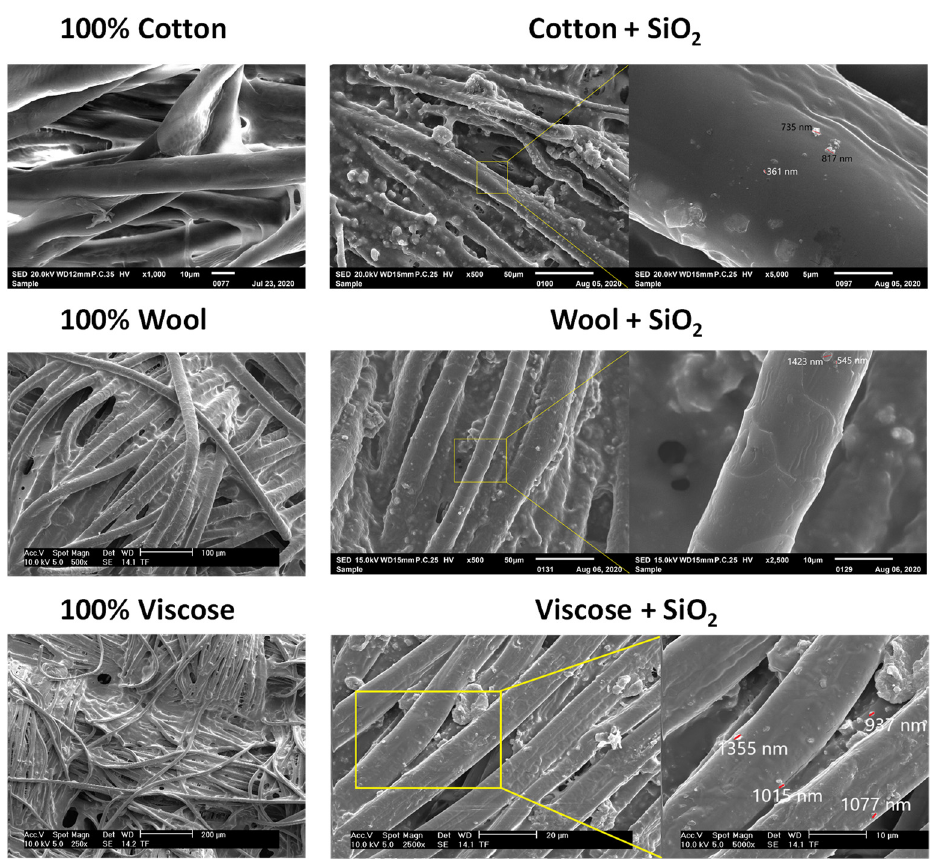
Figure 1. SEM images of uncoated fabrics and related SiO 2 ‐ coated fabrics.